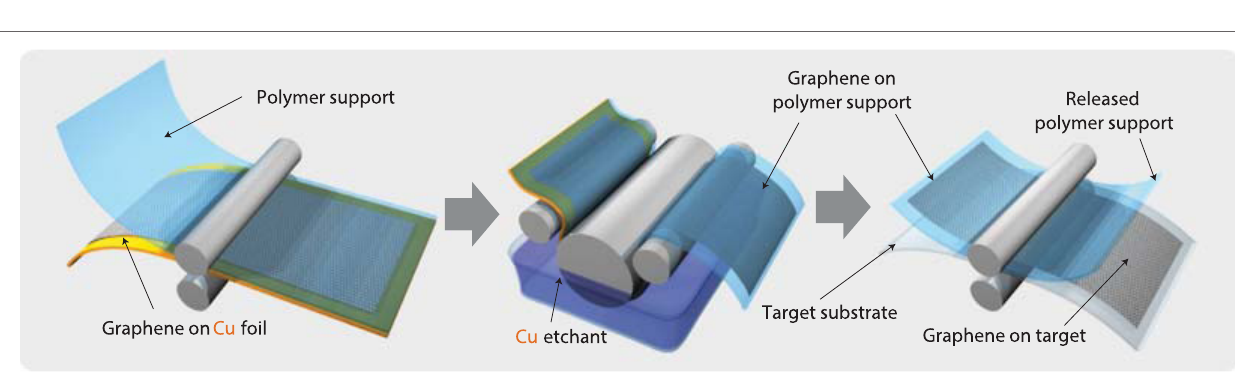
FiGURe 7 | Schematic of the roll-based production of graphene films grown on a copper foil . The process includes adhesion of polymer supports, copper etching (rinsing), and dry transfer-printing on a target substrate. A wet-chemical doping can be carried out using a setup similar to that used for etching (Bae et al., 2010). Copyright Nature Publishing Group,